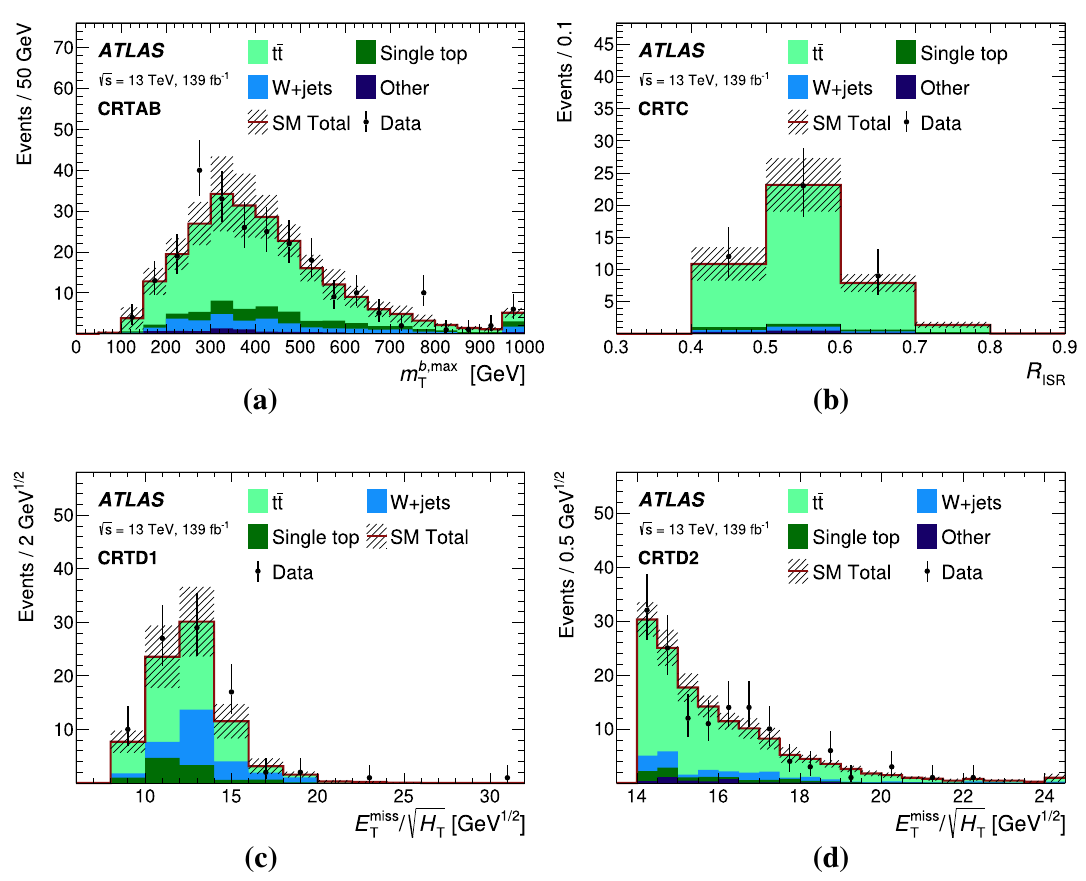
Fig. 6 Distributions illustrating the level of agreement between data (points) and the SM expectation (stacked histograms, after simultane- ously fitting to all backgrounds) in the t ¯ t control regions: a m b , max for CRTAB, b R ISR for CRTC, and E miss